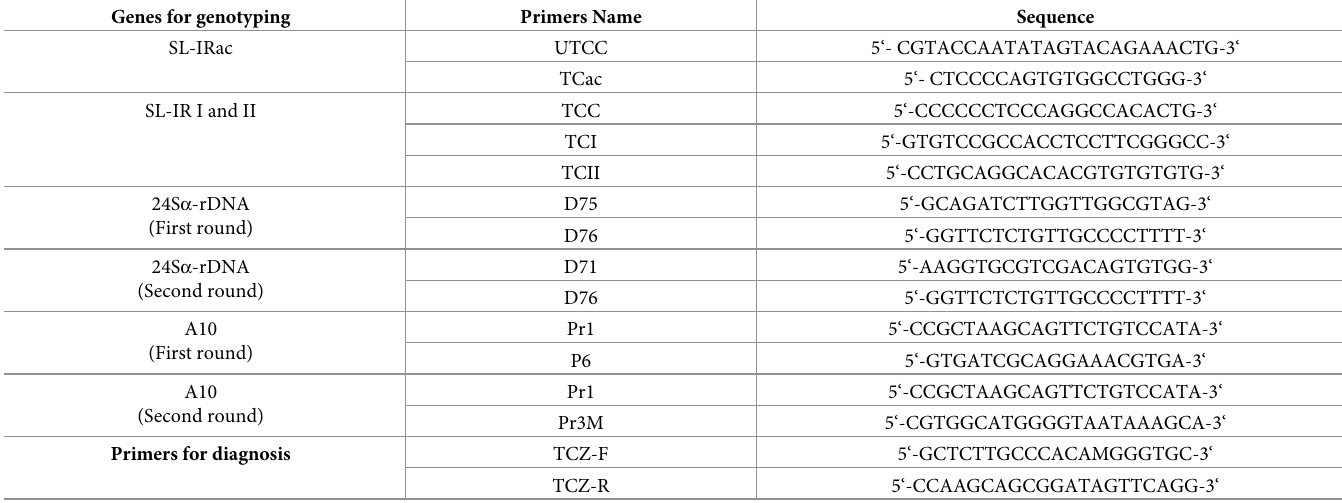
Table 1. Specific primers for T . cruzi genotyping and diagnosis of Chagas disease. Genes for